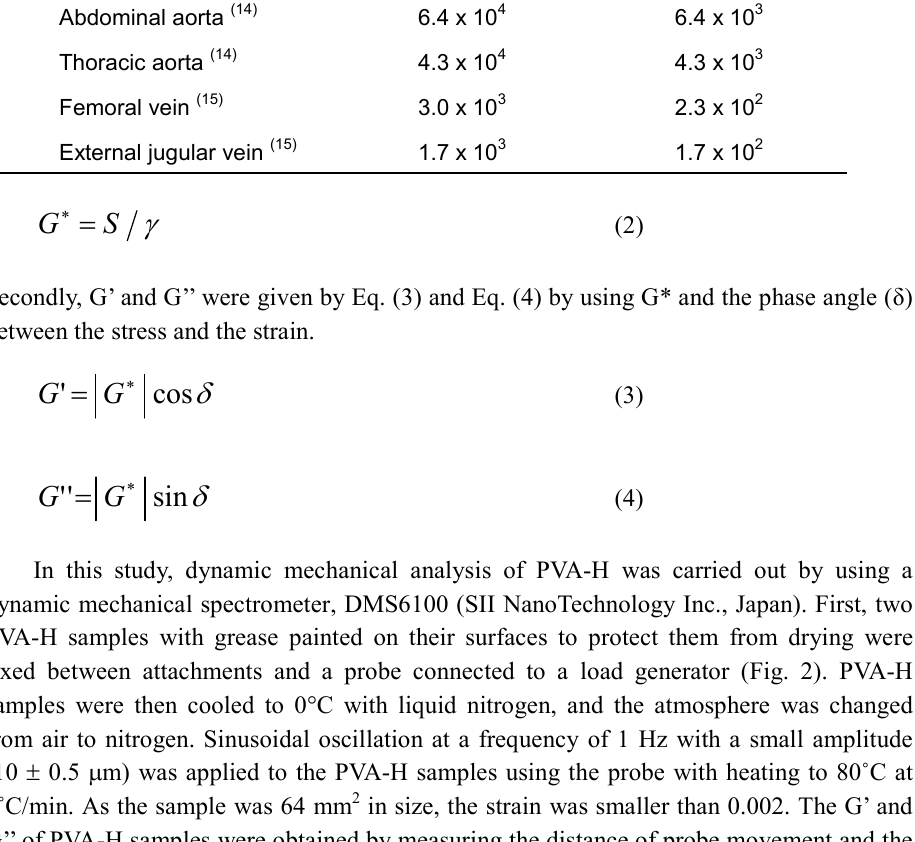
Figure 2 Dynamic mechanical spectrometer Table 2 Dynamic viscoelasticity of blood vessel Blood